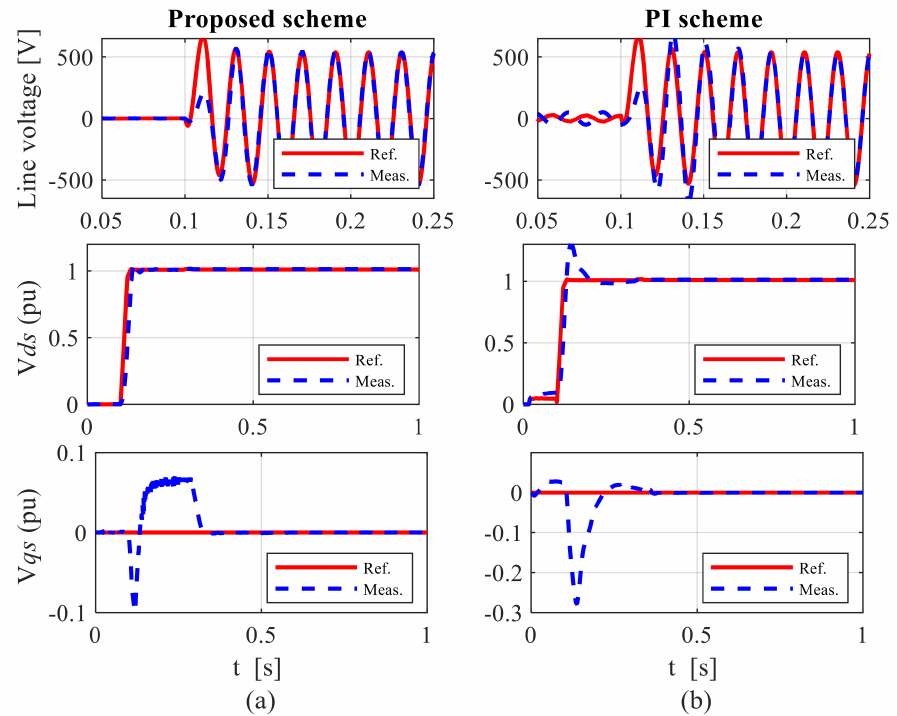
Figure 4. Control performances during super-synchronous speed operation under balanced grid conditions: ( a ) proposed scheme and ( b ) PI